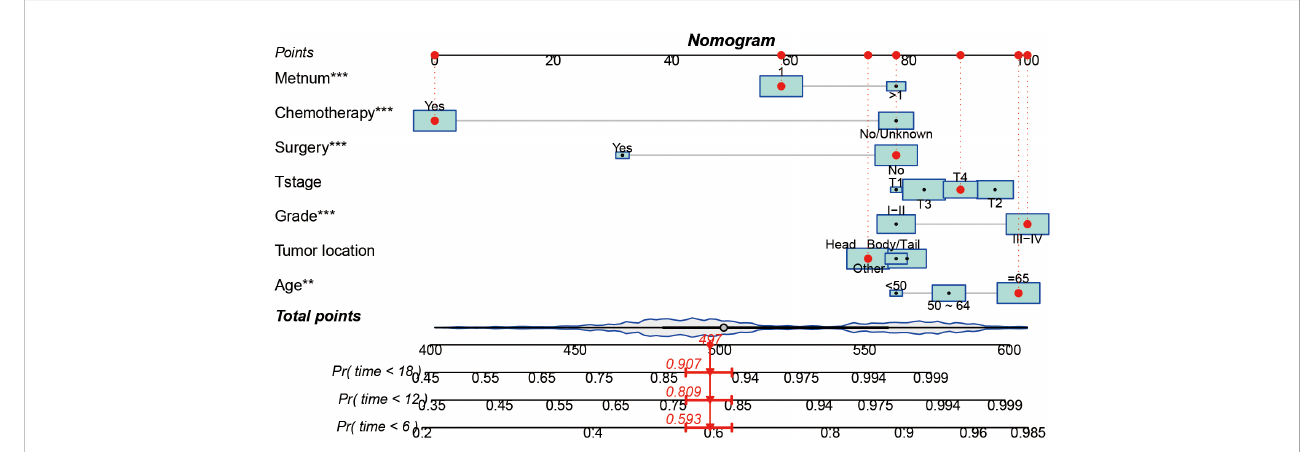
FIGURE 3 A prognostic nomogram for predicting the OS of metastatic PDAC patients for the 6, 12, and 18 months.